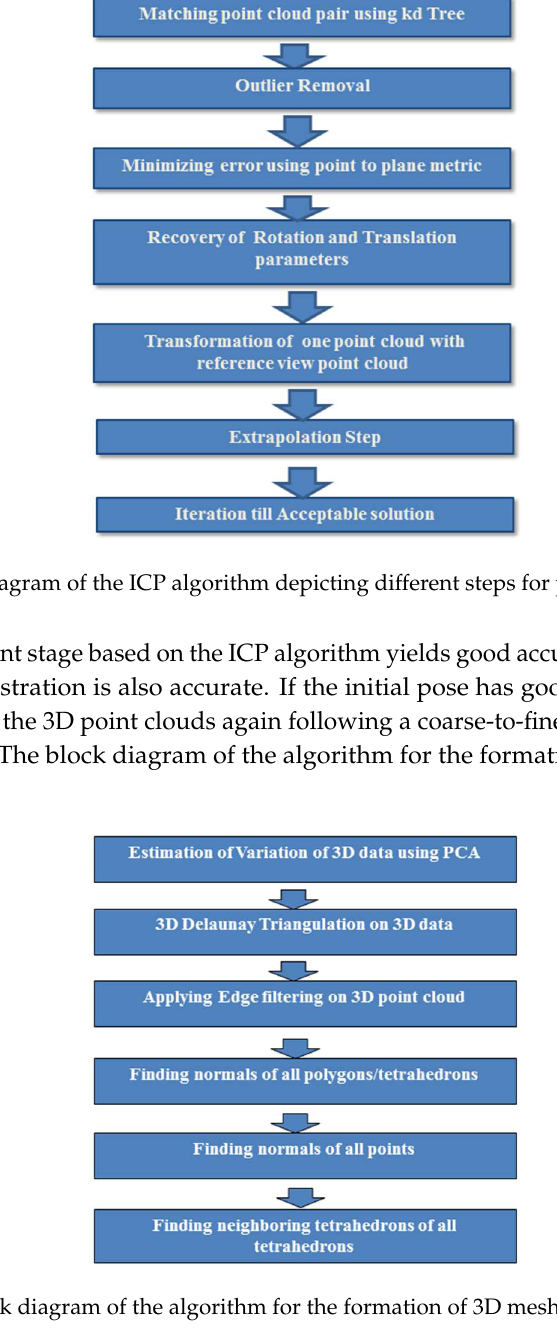
Figure 4. Block diagram of the algorithm for the formation of 3D mesh from point clouds.